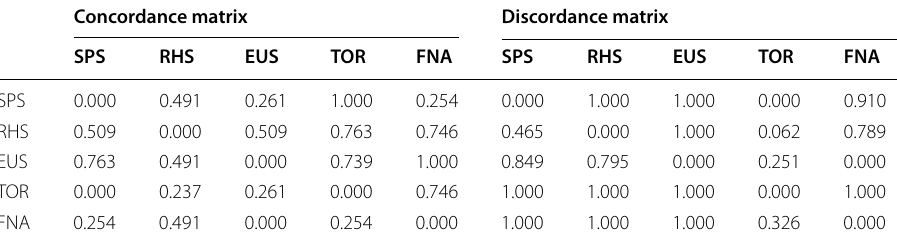
Table 14 Concordance and discordance interval matrixes for the amplitudes of quantum membership degrees Concordance matrix Discordance matrix SPS RHS EUS TOR SPS